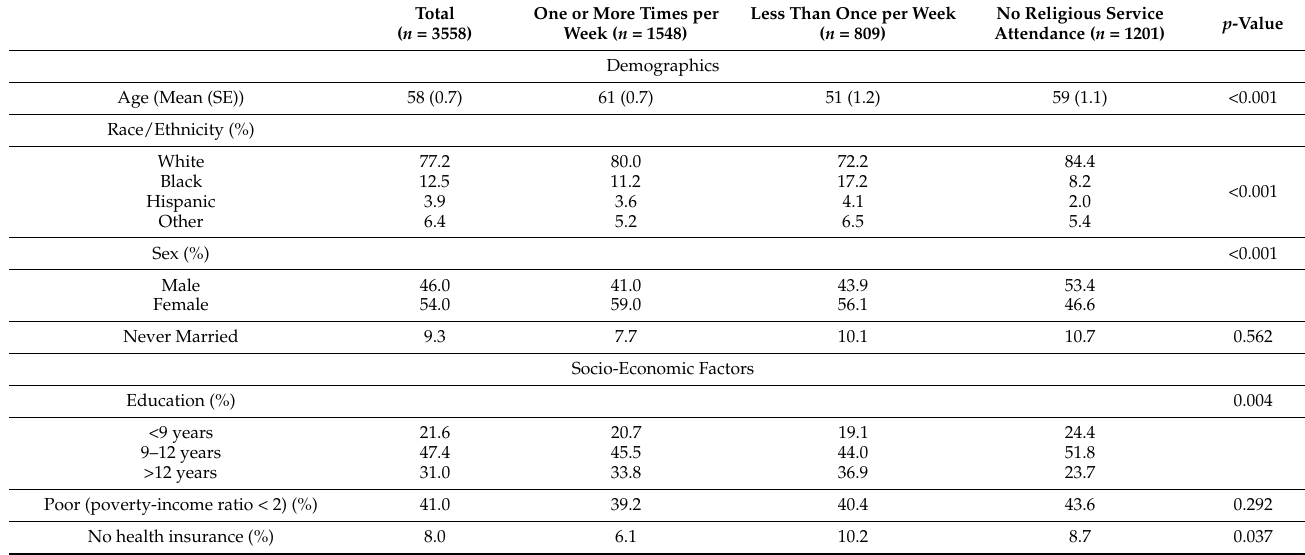
Table 1. Distribution of Sample Characteristics for NHANES III Participants with Chronic Kidney Disease for the Total Sample and by Religious Service